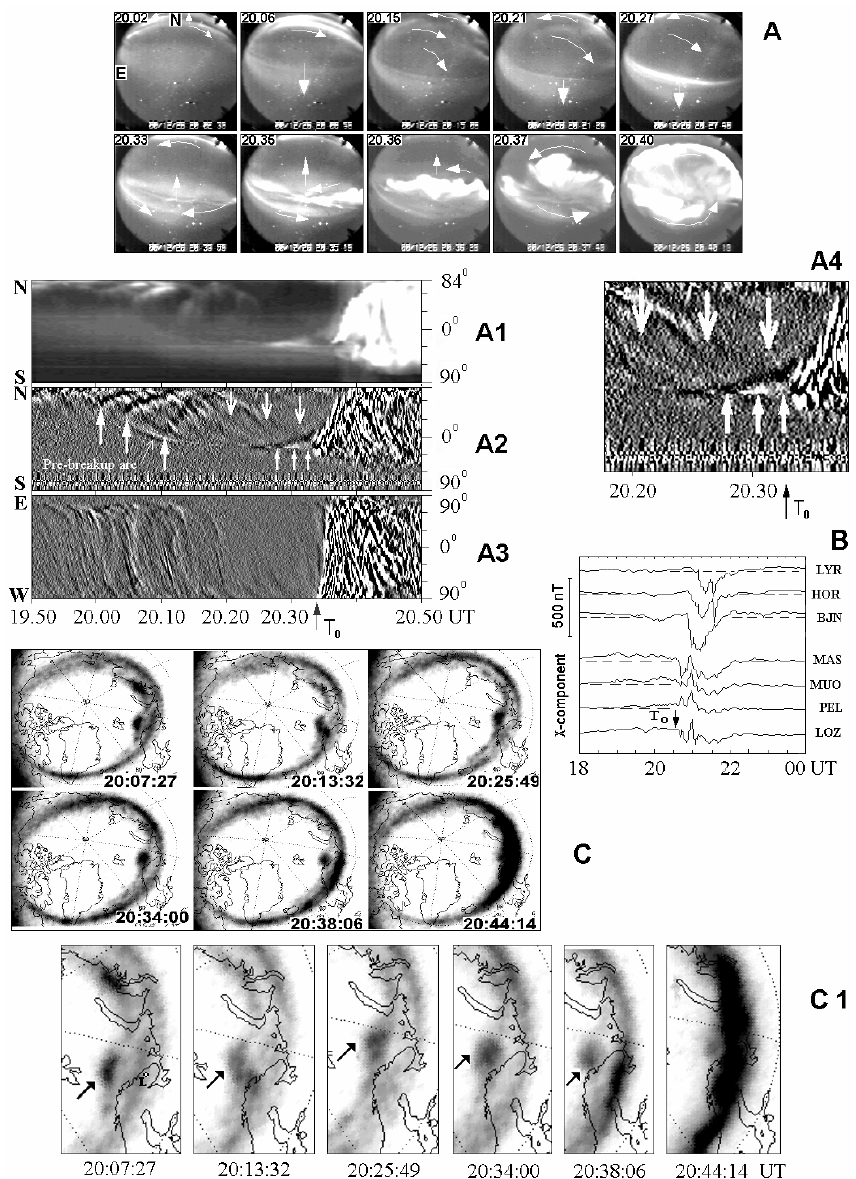
Fig.2 Fig. 2. Sample of data for a moderate breakup that occurred on 26 December 2000. Panels (A) , (B) , (C) , (C1) are the same as in Fig. 1. Panel (A1) is an original keogram from Lovozero; (A2) and (A3) are North-South and East-West filtered keograms; (A4) is an enlarged section of the keogram (A2) demonstrating auroral dynamics in the vicinity of the breakup. Three groups of white arrows in the filtered keogram (A2) indicate three kinds of auroral structures invisible in the original keogram (A1) , these structures show a relation between auroral activity across the auroral oval and are probably breakup